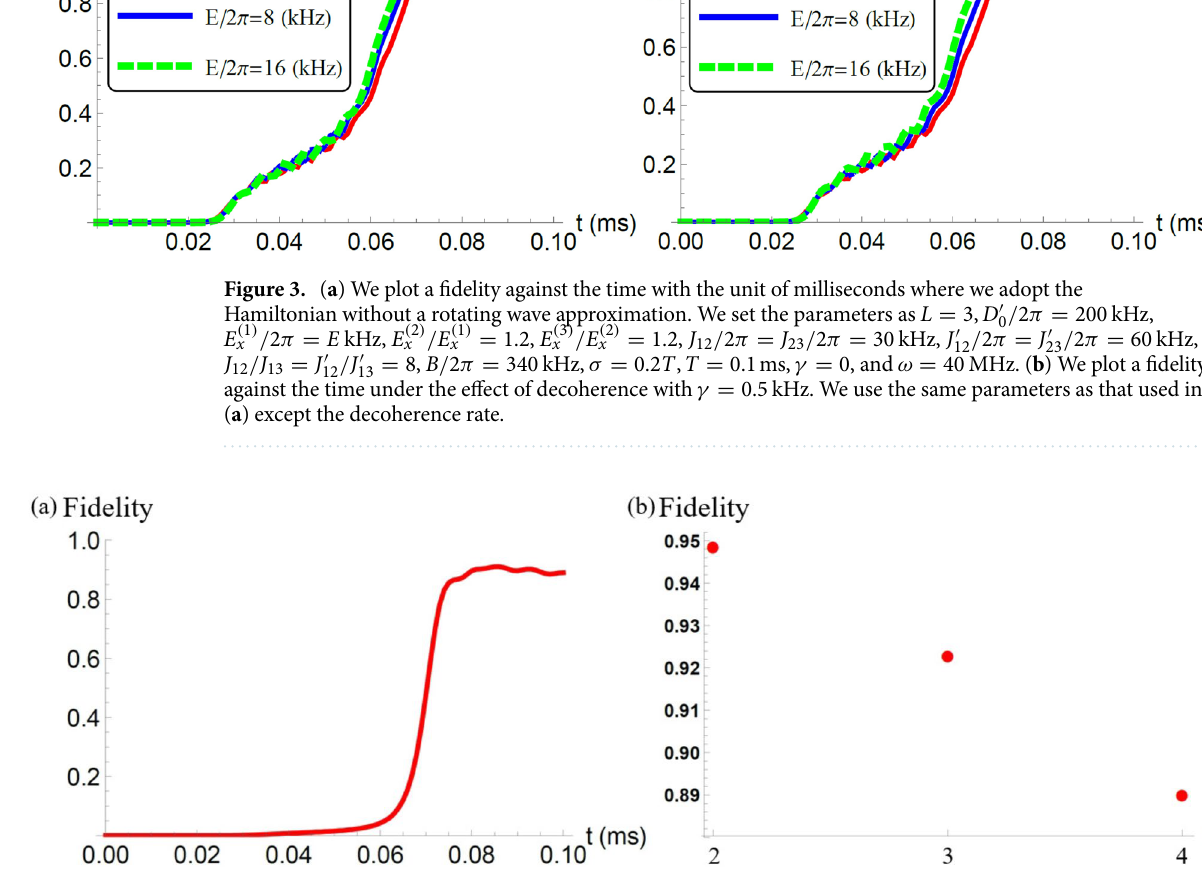
Figure 4. ( a ) We plot a fidelity against the time with the unit of milliseconds where we adopt the 200 Hamiltonian with a rotating wave approximation. We set the parameters as L = 4, D ′ 0 / 2 π = ( 1 ) 2 π 3 kHz, J 12 / 2 π 30 kHz, E ( 2 ) x / 2 π E ( 3 ) x / 2 π E ( 4 ) x / 2 π J 23 / 2 π J 34 / 2 π kHz, E x / = = = = = = = 60 kHz, J 12 / J 13 8 , J 12 / J 14 27 , J ′ 12 / 2 π J ′ 23 / 2 π J ′ 34 / 2 π J ′ 12 / J ′ 13 J 23 / J 24 J ′ 23 / J ′ 24 J ′ 12 / J ′ 14 = = = = = = = = = 0.2 T , T 0.1 ms, and, γ 340 kHz, σ 0.5 kHz. ( b ) We plot the fidelity agains the number of B / 2 π ( j ) = = = = 2 π 3 kHz for qubits where we adopt the Hamiltonian with a rotating wave approximation. We choose E x / = 1, 2, 3, 4 . For L 3 , we use the same parameters as that used in Figs. 2 and 3 except the strain. 2 and L j = = = 4 , we use the same parameters as that used in ( a For L =